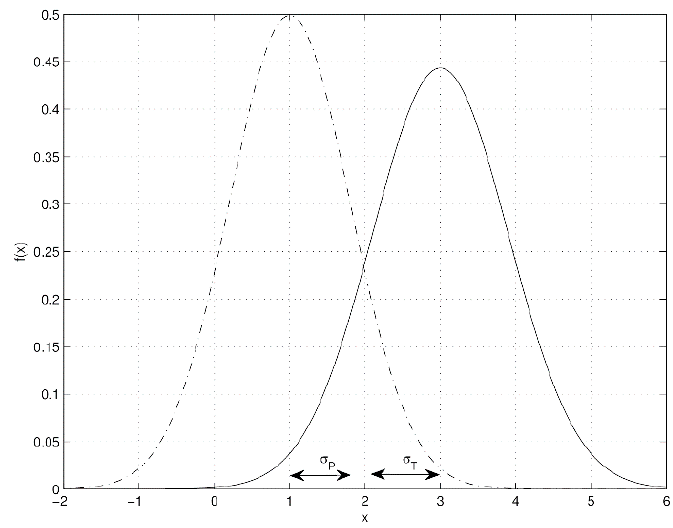
Figure 2. Example of a distribution curve when technology and pen-and-paper are qualitatively different.